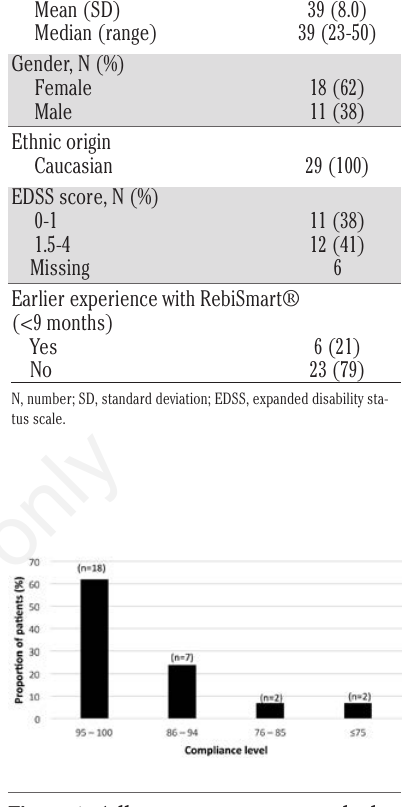
Figure 1. Adherence to treatment calculat- ed from device data.